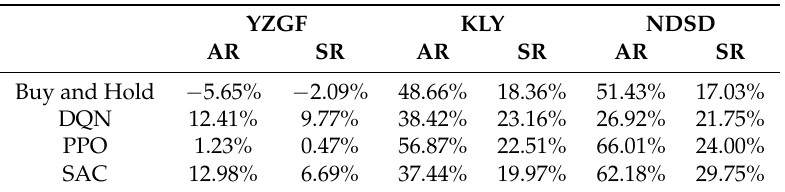
Table 2. Results in test